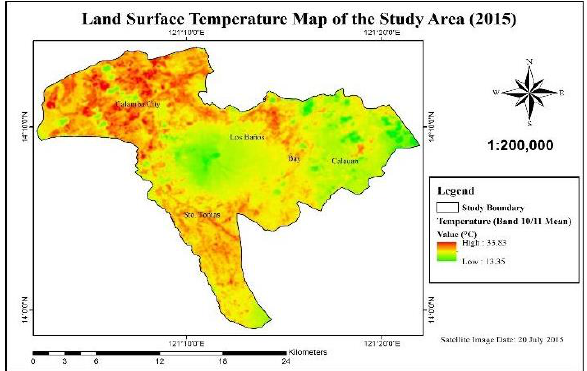
Figure 7. Land surface temperature map of the averaged bands 10 and 11 TIR band of Landsat 8 dated July 20,